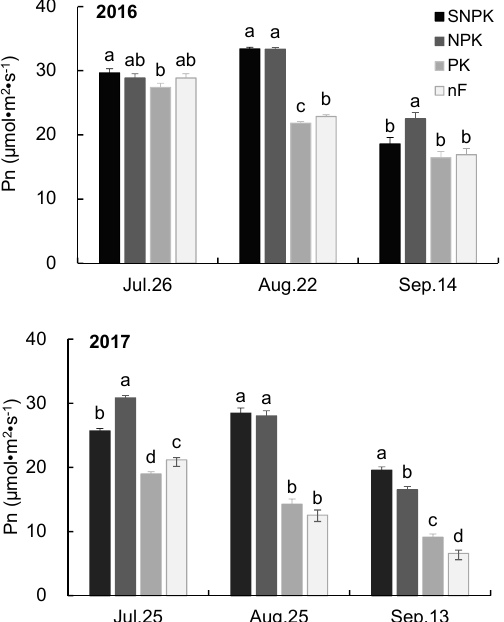
Figure 4. Photosynthesis rates ( Pn ) of maize ear leaf at the flowering stage (July 26 in 2016-A and July 25 in 2017-B), middle grain-filling stage (August 22 in 2016 and August 25 in 2017), and near maturity (September 14 in 2016 and September 13 in 2017) as an e ff ect of long-term fertilizer treatment SNPK, NPK, PK, and nF. SNPK represents a combination of maize straw, chemical nitrogen, phosphorus, and potassium, NPK represents the treatment of chemical nitrogen, phosphorus, and potassium, PK represents chemical phosphorus and potassium, and nF represents no fertilizer. Values with the same letter are not significantly di ff erent at p < 0.05, comparison within the same measuring date. Bars: Standard error of the